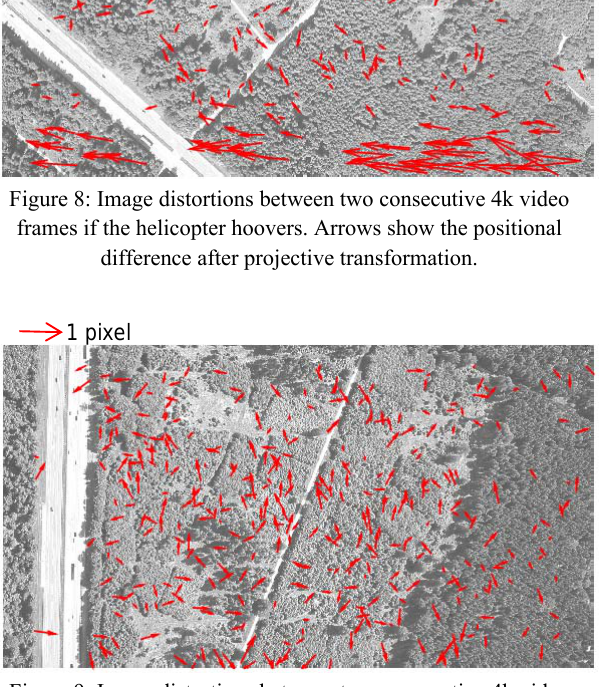
Figure 9: Image distortions between two consecutive 4k video frames if the helicopter goes with standard speed. Arrows show the positional difference after projective transformation.